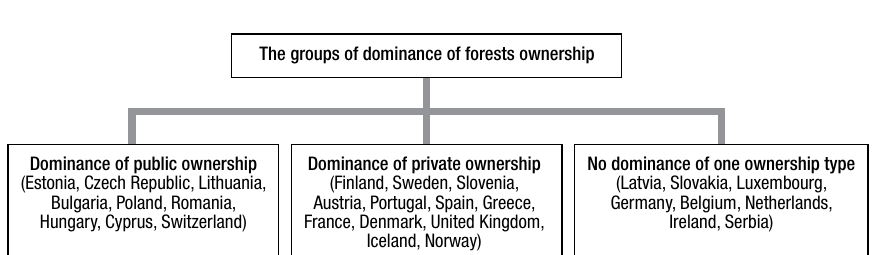
Fig. 5. Forest ownership: shares of public and private ownership (2005) Source : The EU Forest … (2006: 7)